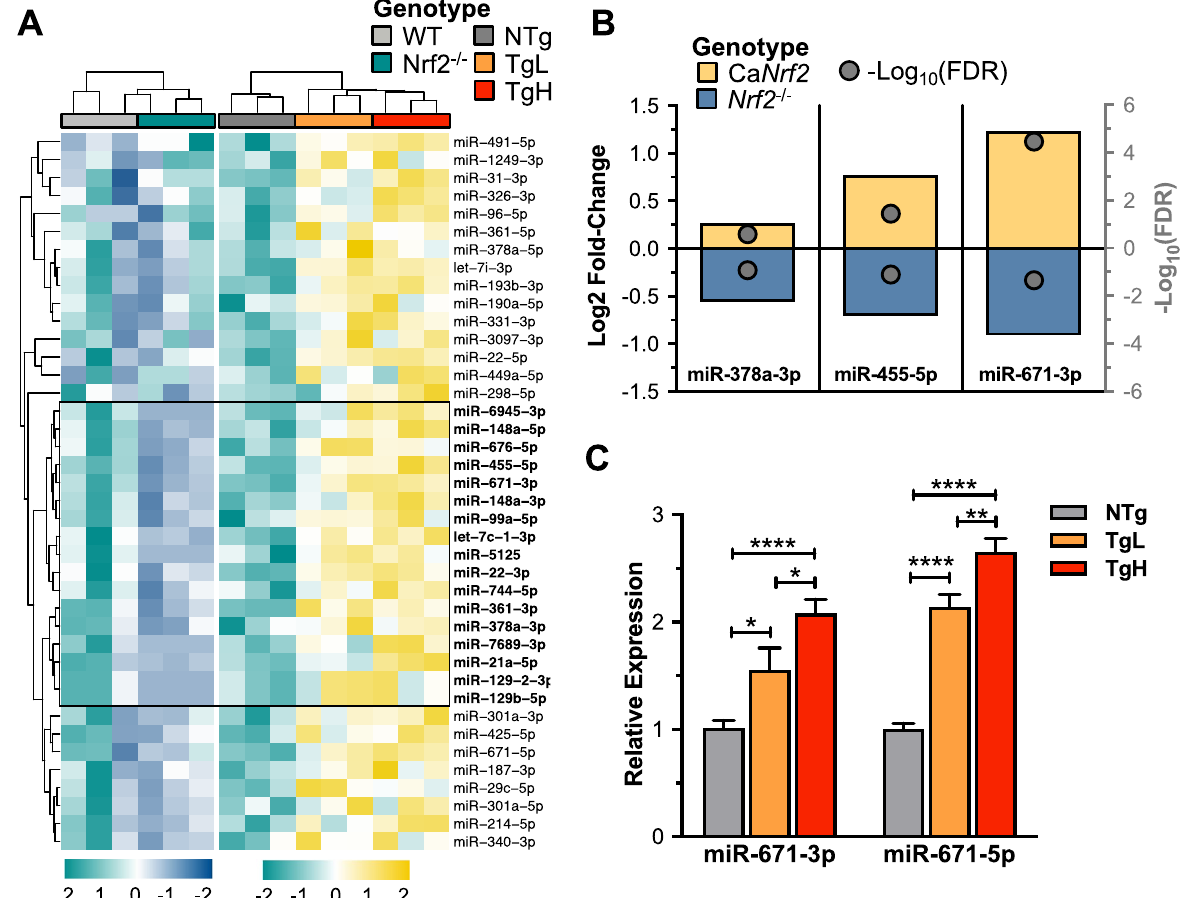
Figure 6. Nrf2 is both necessary and sufficient to induce reductomiR expression. ( A ) Quantitative realtime PCR (qPCR)-based candidate validation of 3 miRNAs found to reach significance (n = 3, P < 0.05) with inverse expression between Nrf2 knockout ( Nrf2 −/− , Table S11) and Ca Nrf2 -Tg (Table S1) mouse models: miR-378a-3p, miR-455-5p, and miR-671-3p. ( B ) qPCR validation of ca Nrf2 -Tg miRNA sequencing analysis. Benjamini- hochberg (BH)-adjusted t-test was performed with ****P < 0.0001, ***P < 0.001, **P < 0.01, *P < 0.05 reported as mean ±